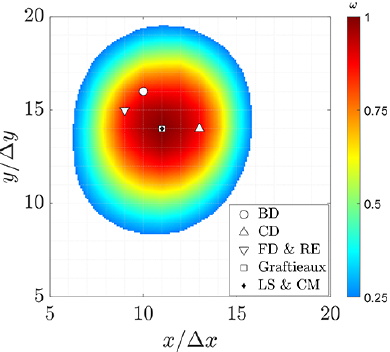
Figure 9. Vortex center locations for different differentiation schemes. The vorticity magnitude contour based on the least- squares scheme is